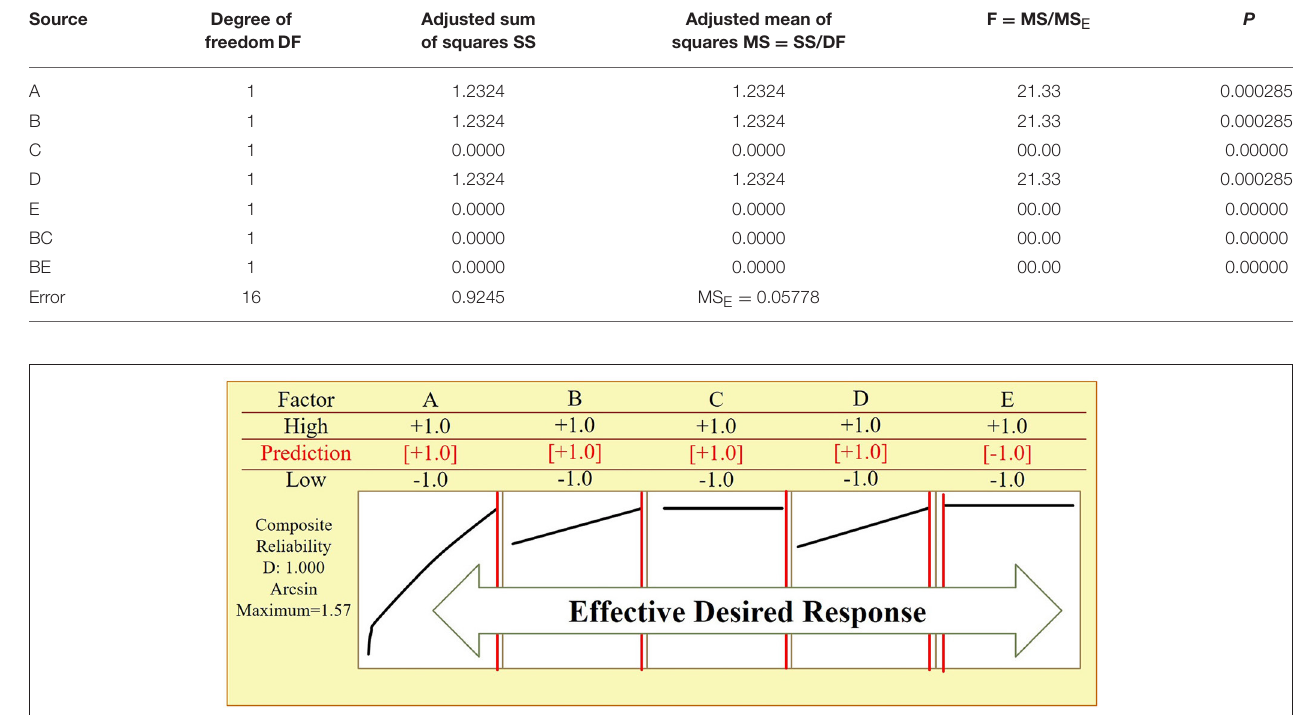
FIGURE 5 | Predicted recipe based on the DoE analysis indicating high levels of factors “A,” “B”, “C,” “D” while low level of factor “E” will result in effective desired response of synthesizing Graphene.